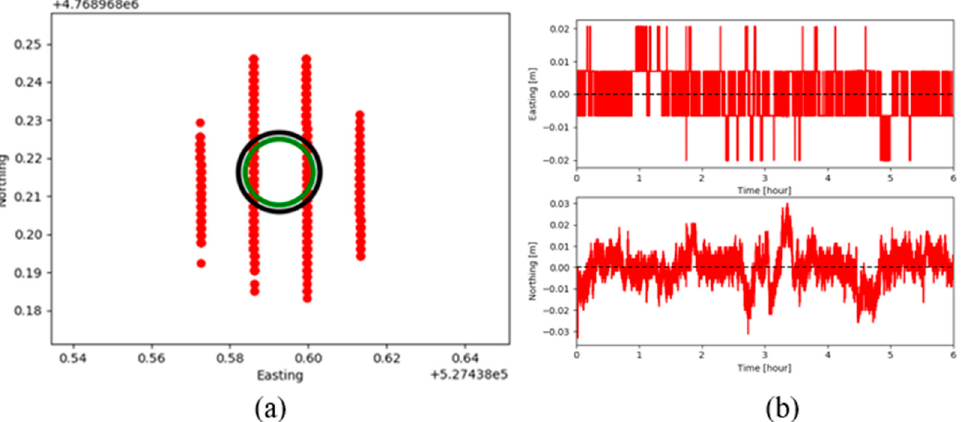
Figure 5. Static positioning experiment results of the Real Time Kinematic (RTK) positioning augmentation system. ( a ) Easting vs. Northing, ( b ) Time series; the red points are the position points, the measurement within the circle in black is the twice distance root mean square (2DRMS), the radius of the circle in green is the circular error probability (CEP).